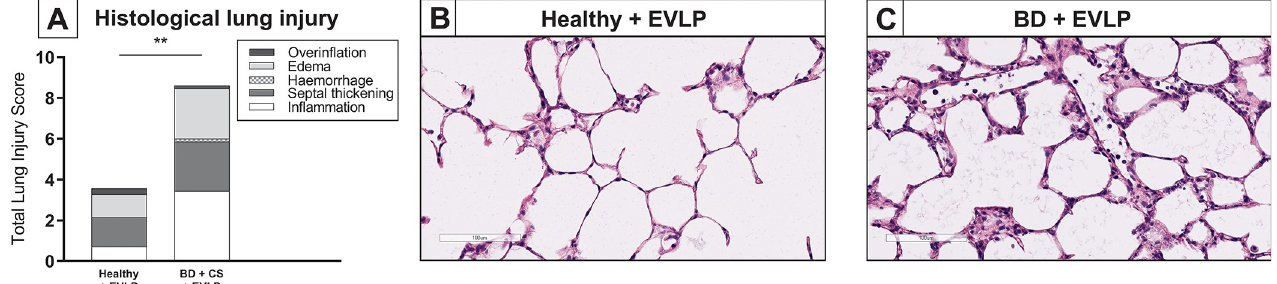
Fig 8. Lung morphology after ex vivo lung perfusion. Lungs from healthy donor rats or rats subjected to 3 hours of brain death (BD) and 1 hour cold storage (CS) were ex vivo perfused for 6 hours (EVLP, experimental group 3 and 4). Histological lung injury was scored after staining for hematoxylin and eosin (H&E). (A) Quantification of lung injury scores after EVLP in H&E-stained lung slides. (B-C) Representative H&E-stained slices of healthy donor lungs and lungs from brain-dead donors, after EVLP. �� p < 0.01 in healthy donor lungs versus lungs from brain-dead donors subjected to EVLP.